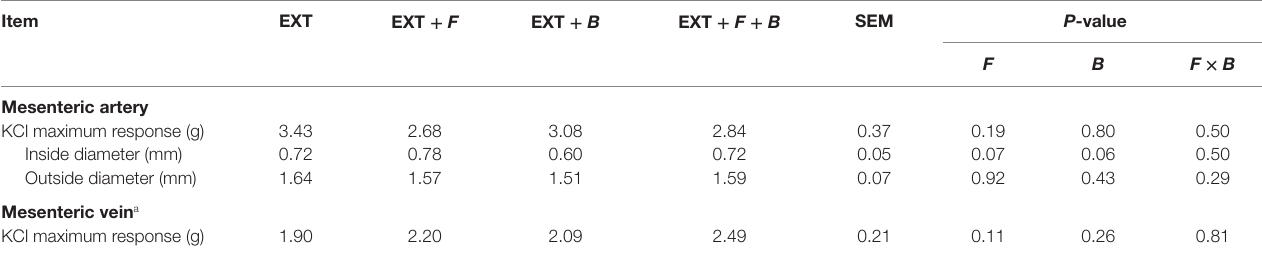
TaBle 2 | inside diameter, outside diameter, and seM of mesenteric artery, and the mean Kcl maximum response of mesenteric artery and vein to pretreatment with tall fescue seed extract: 1 × 10 − 6 M ergovaline-containing tall fescue seed extract (eXT); combinations of 1 × 10 − 6 M eXT and formononetin ( F ), eXT and biochanin a ( B ), and the combination of eXT + F + B .